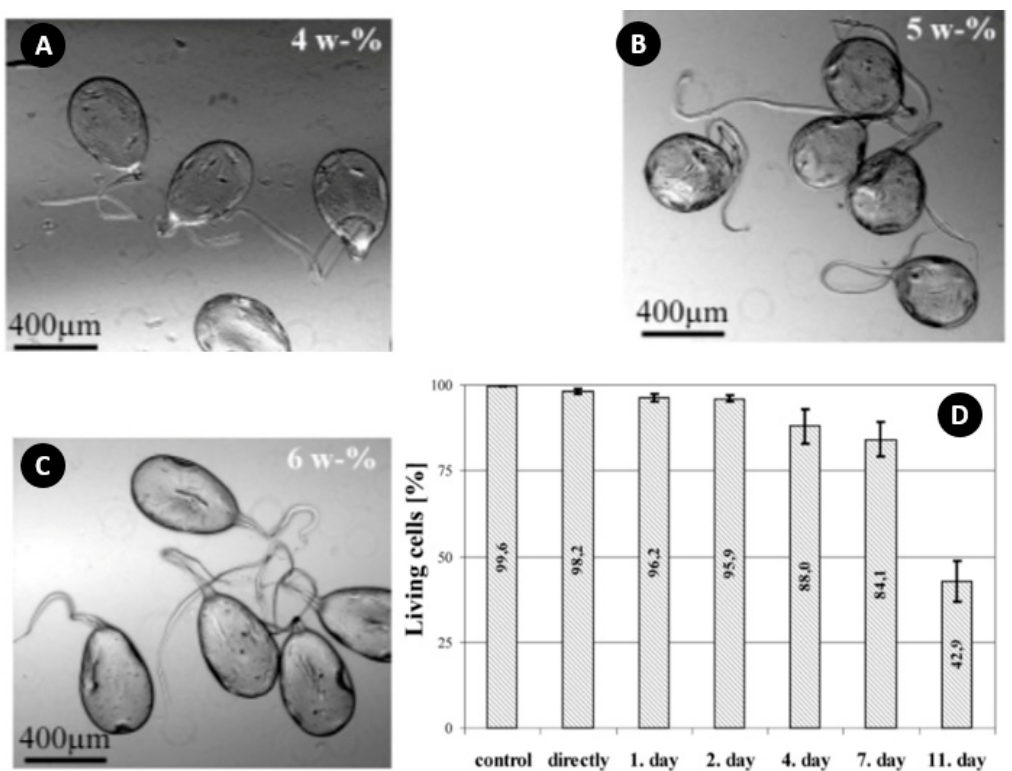
Figure 8. ( A – C ) Microbeads produced by different concentrations (4, 5, and 6 wt%) of Na-alginate solution; ( D ) Cell vitality before and after encapsulation (PC12). Reprinted with permission from [42]. Chen et al. used a microchannel array (MiCA) for the production of water-in-oil emulsions [64]. In